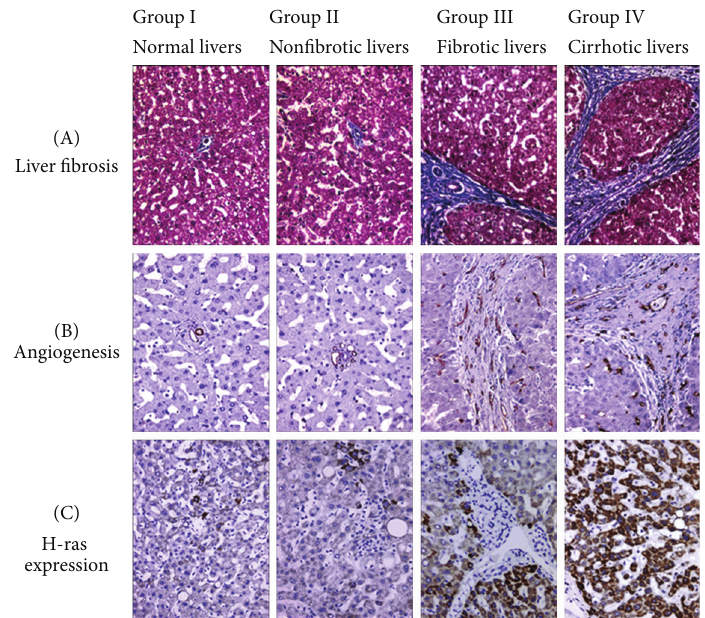
Figure 1: Liver fibrosis (A), angiogenesis (B), and H-ras expression (C) in the study group. In normal livers, the number of CD34 labeled vessels ∗ and H-ras positive cells ∗ is lower when compared to DEN-treated livers. In the latter, their number increases according to the extent of fibrosis ( ∗ brown color staining).